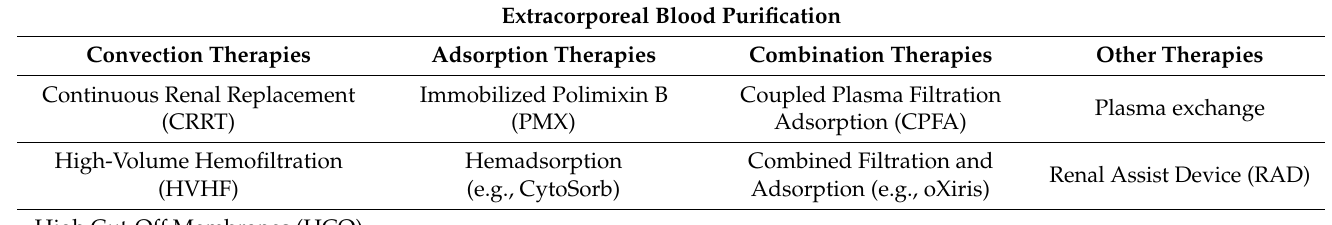
Table 3. Graphical overview of the current available devices to perform blood purification in critically ill patients affected by septic